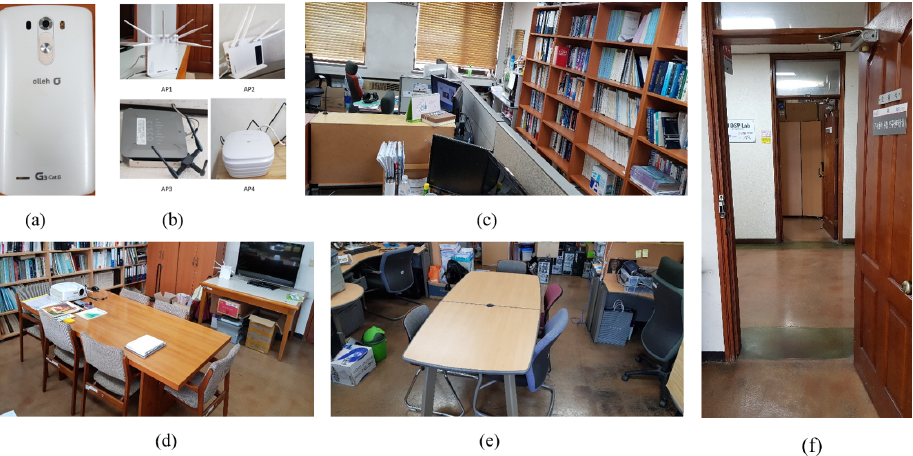
Figure 5. Smartphone, access points (APs) and experiment rooms. ( a ) Smartphone. ( b ) Wi-Fi APs. ( c ) Room-509. ( d ) Room-511. ( e ) Room-512. ( f )